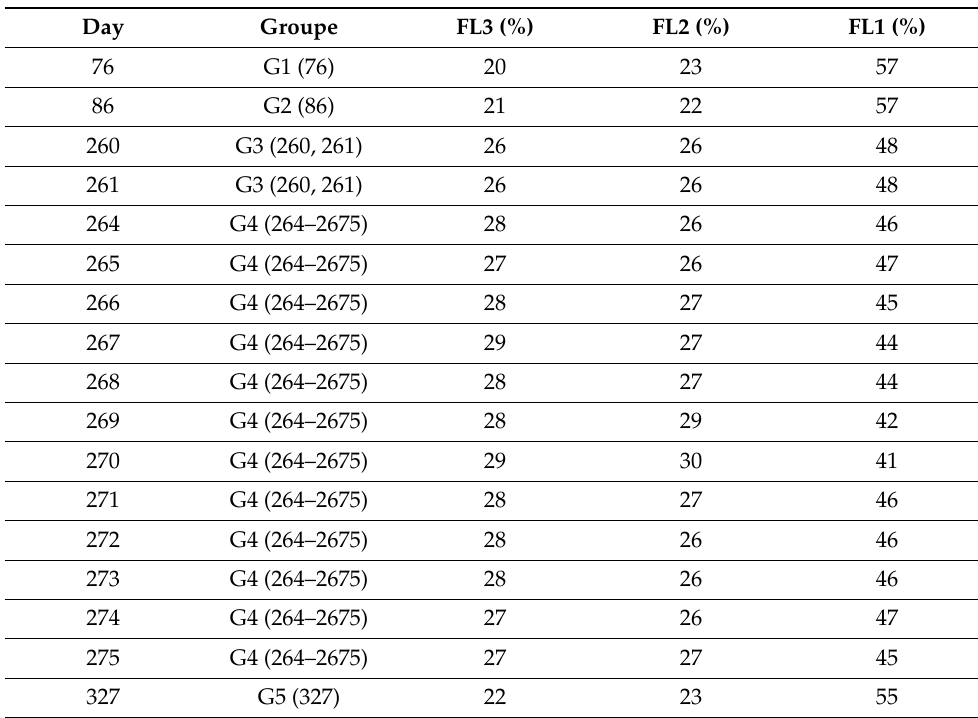
Table 12. Repartition of the water supply ratios related to leak